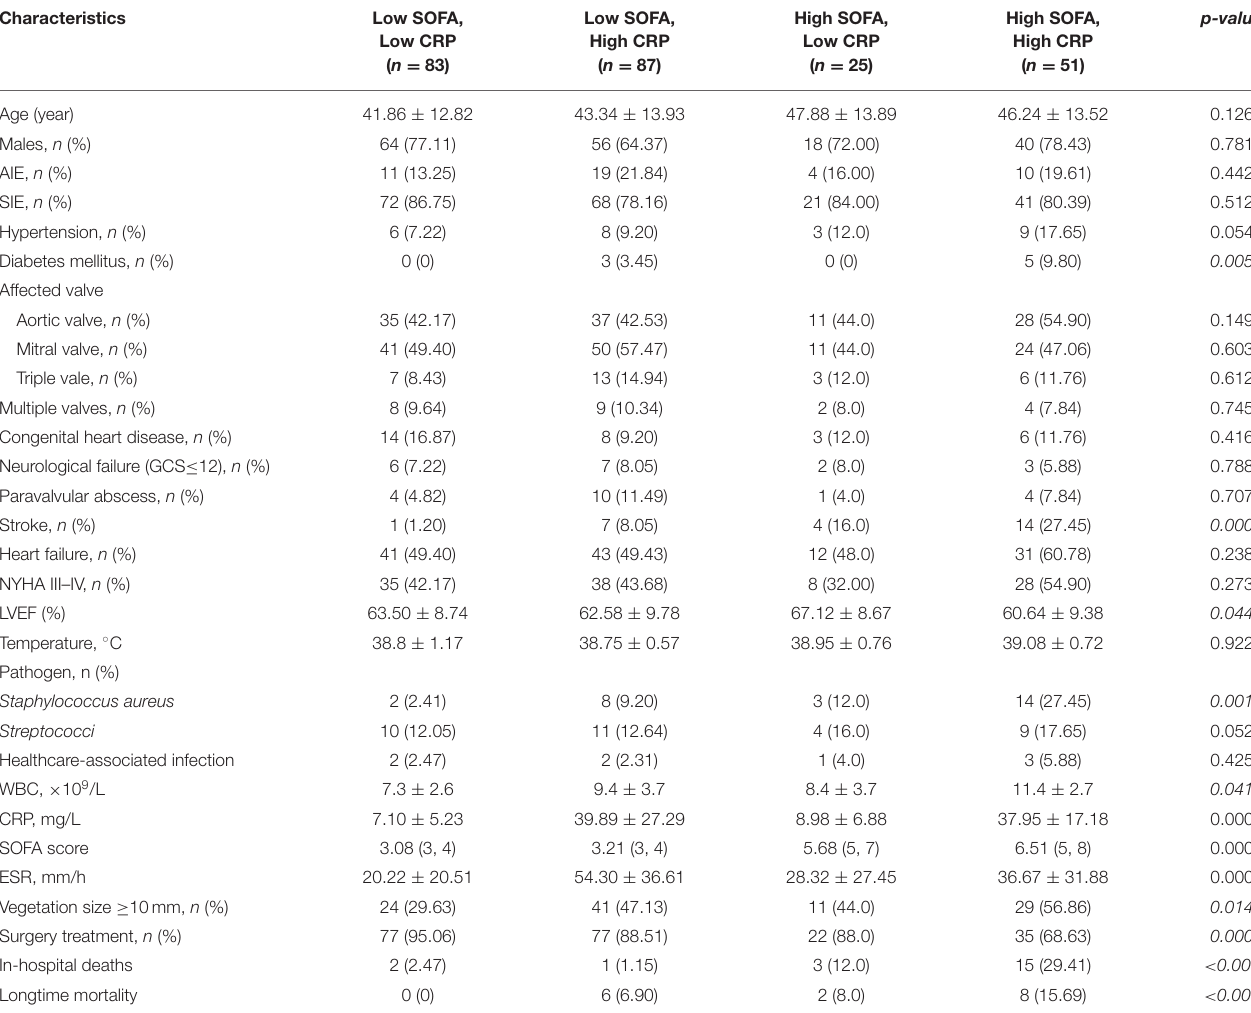
TABLE 1 | Baseline clinical characteristics of patients according to SOFA and CRP.